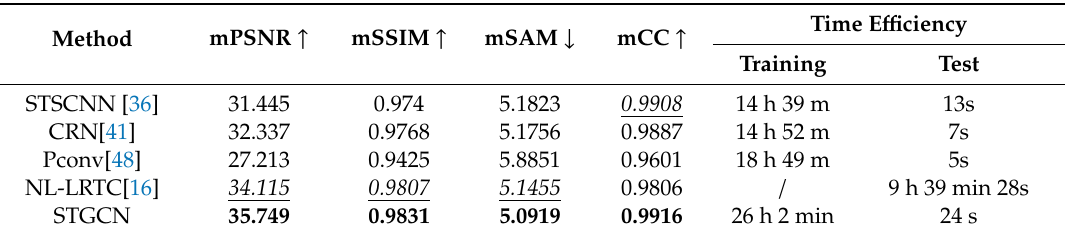
Table 2. Average quantitative evaluation of di ff erent algorithms on simulated clouds of the whole WHU dataset. The best value of each indicator is bolded.